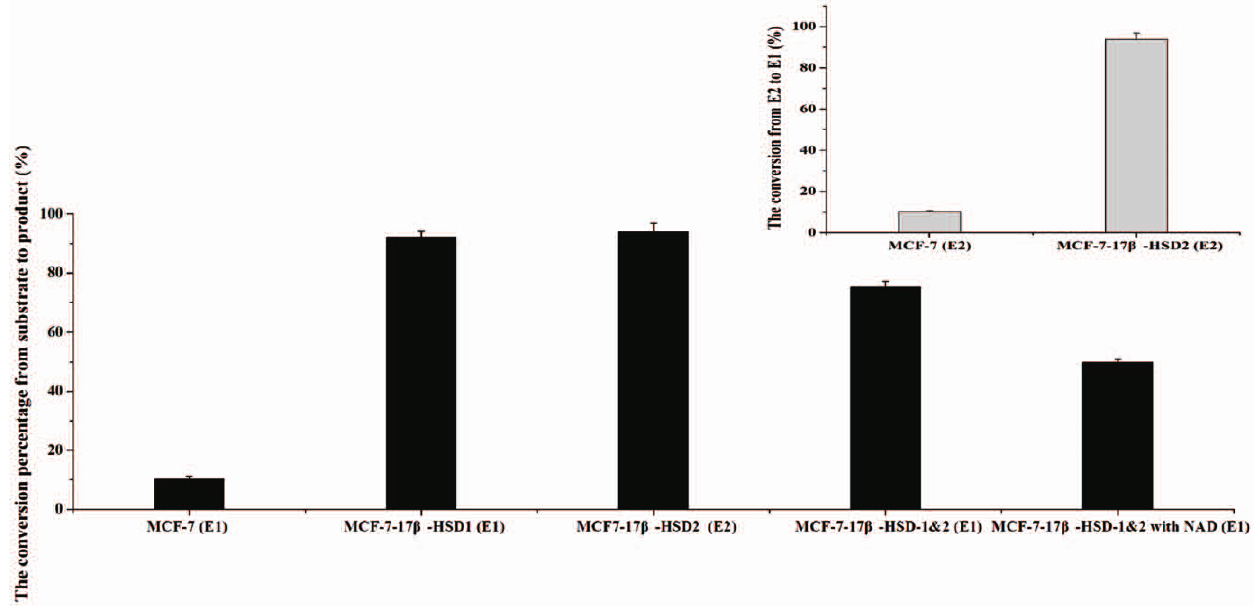
Figure 5. The conversion from substrate to product in MCF-7, MCF-7-17 b -HSD1, MCF-7-17 b -HSD1&2, MCF-7-17 b -HSD1&2 with adding 0.5 mM NAD. Except MCF-7-17 b -HSD2 using E2 as the substrate, E1 was chosen as the substrate in MCF-7, MCF-7-17 b -HSD1 and MCF-7- 17 b -HSD1&2.